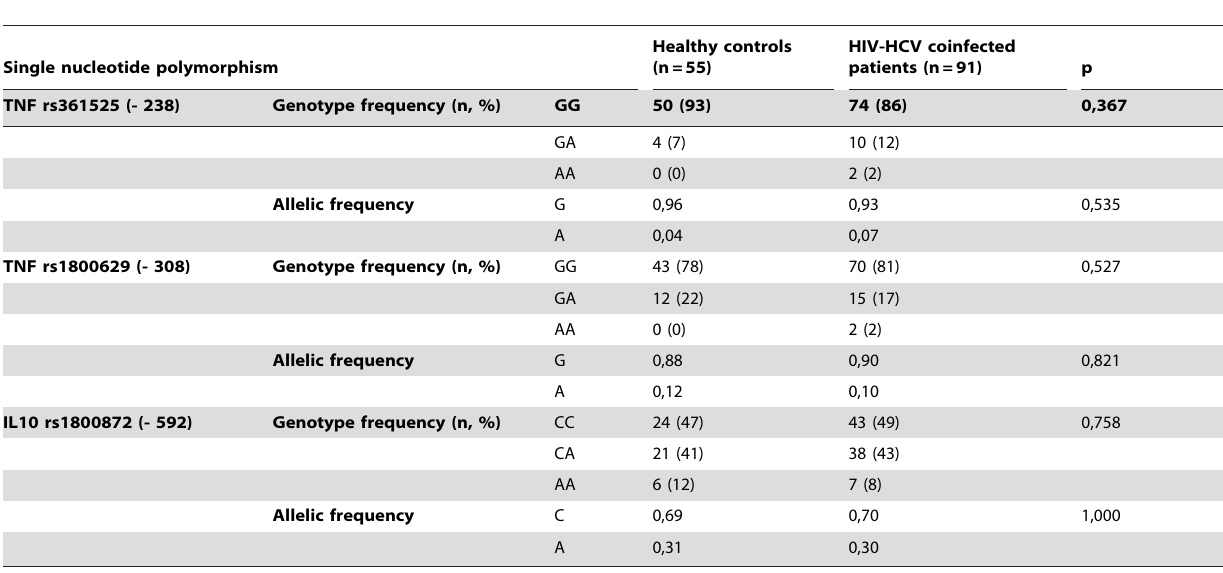
Table 1. Single nucleotide polymorphism of TNF- a and IL-10 genes studied in healthy controls and patients with HIV-HCV